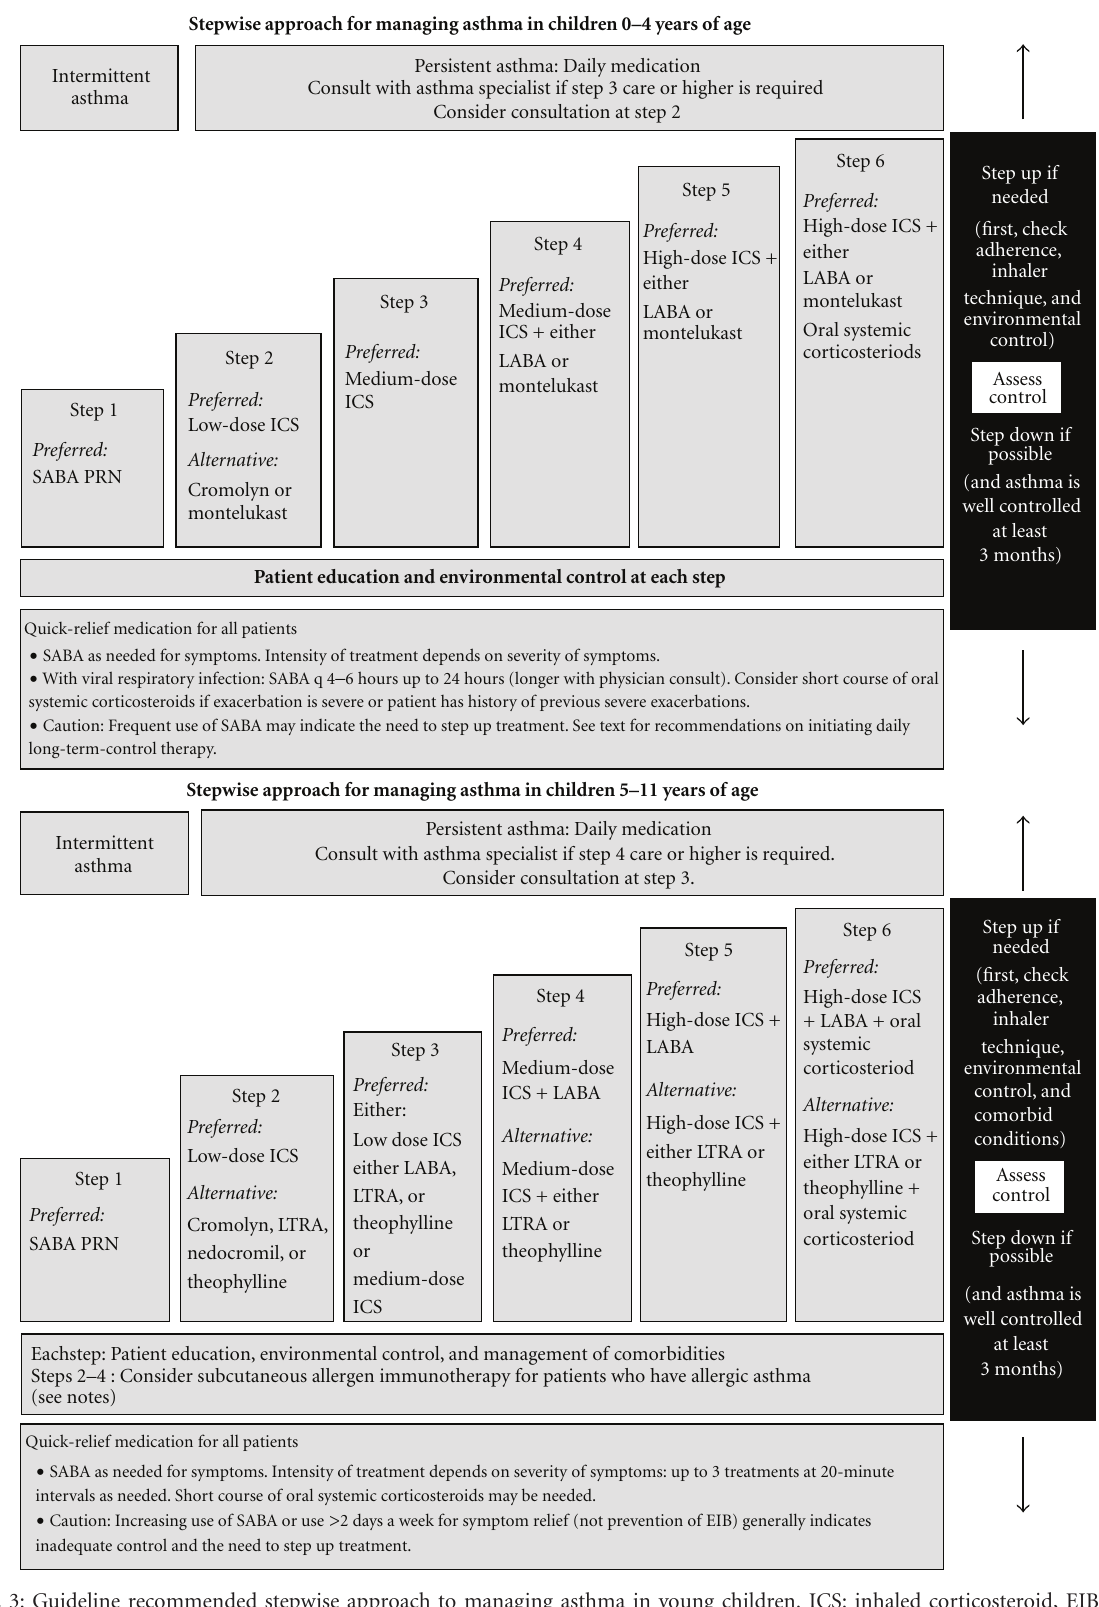
Figure 3: Guideline recommended stepwise approach to managing asthma in young children. ICS: inhaled corticosteroid, EIB: exercise induced bronchospasm, LABA: long-acting β 2 -agonist, LTRA: leukotriene receptor antagonist, and SABA: short-acting β 2 -agonist, reproduced from